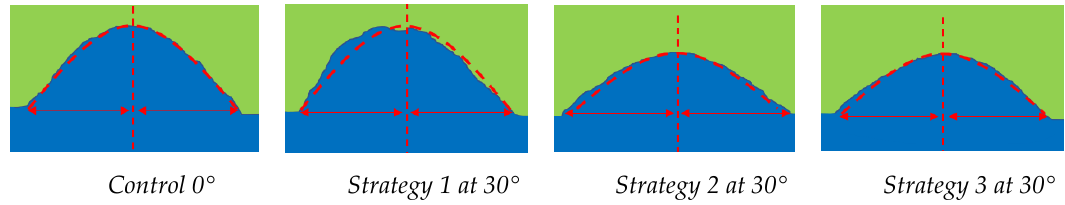
Figure 13. Comparison of the clad shapes (blue color) with the empirical model (red line) when using a four-stream nozzle at different strategies and angles, at v = 500 mm·min −1 . The aspect ratio increases, and the wetting angle decreased with Strategy 2 and Strategy 3.